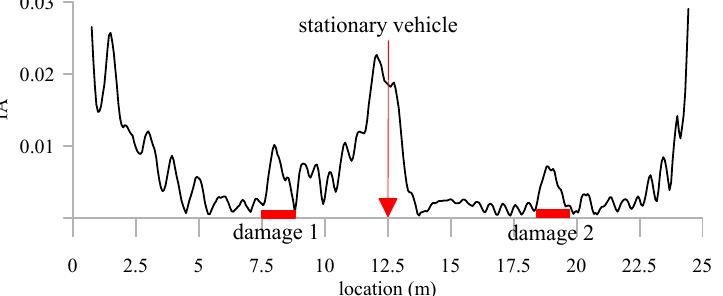
Figure 10. IA of the IMF of contact-point response of the stationary vehicle on a bridge with multiple damage.